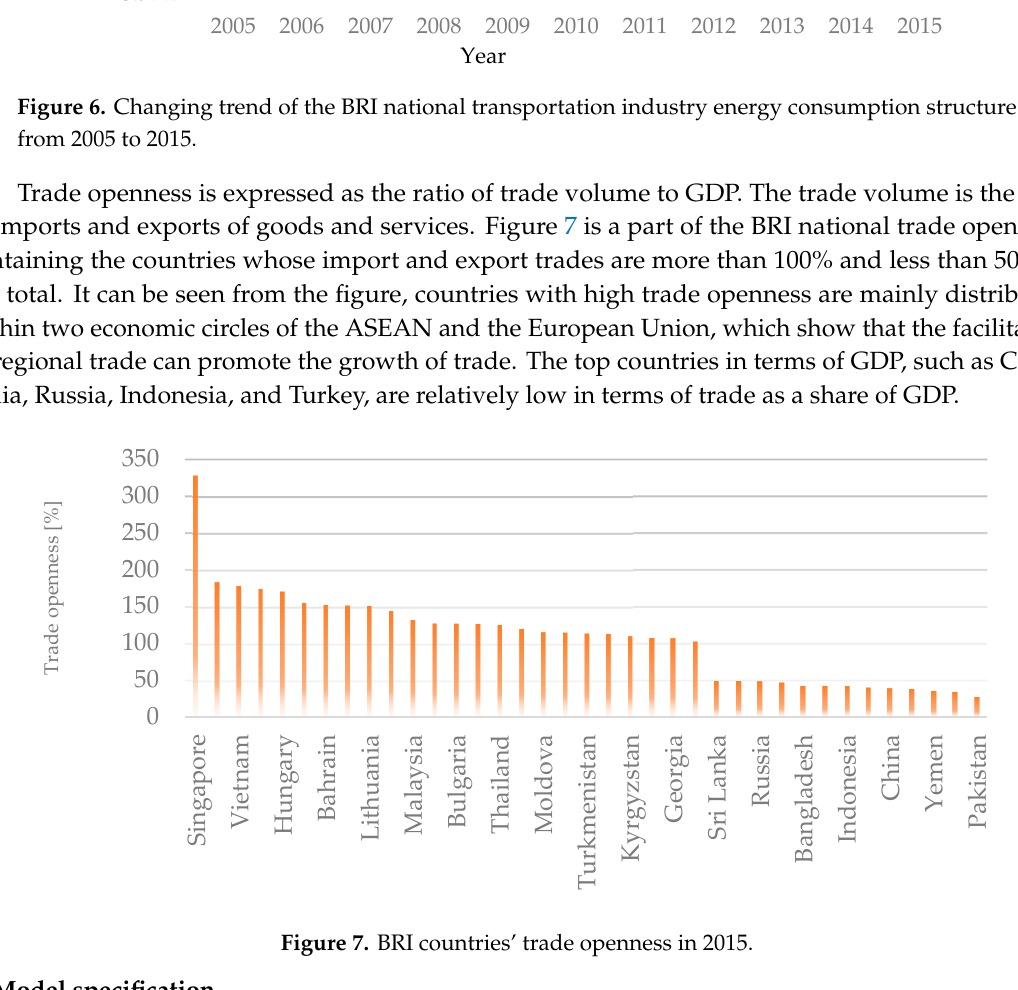
Table 3. Descriptive statistics of variables.